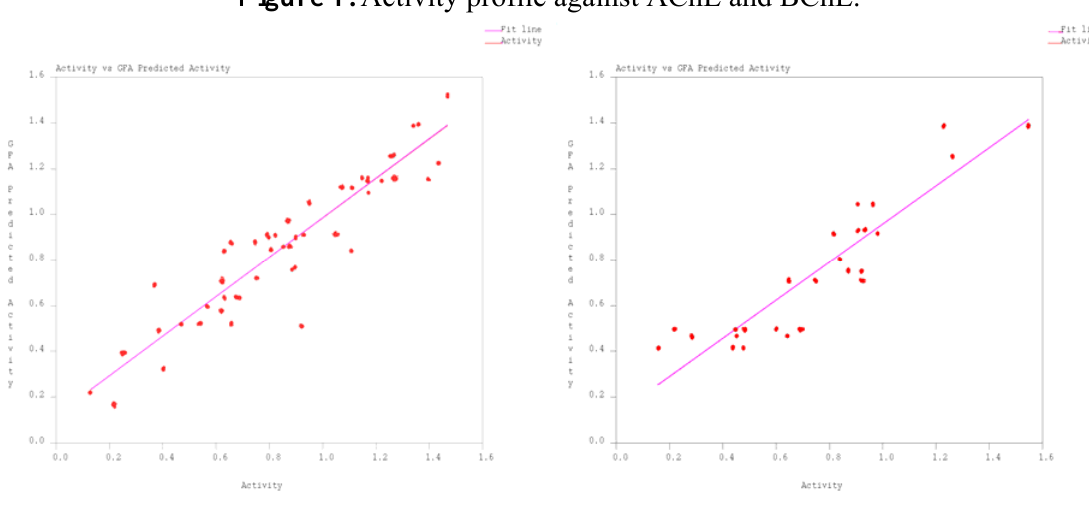
Figure 1. Activity profile against AChE and